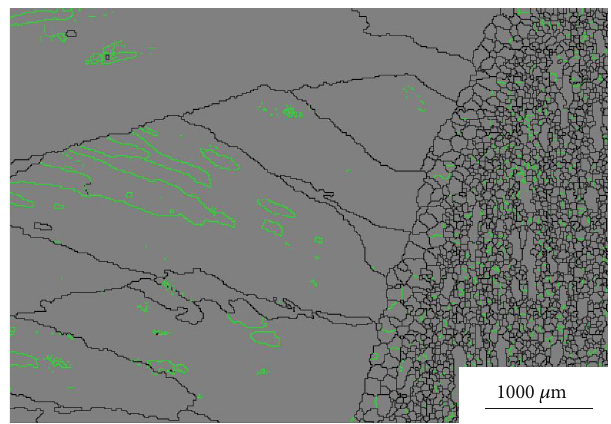
Figure 3: The grain boundary diagram of the 3A21/7075 cladding material.